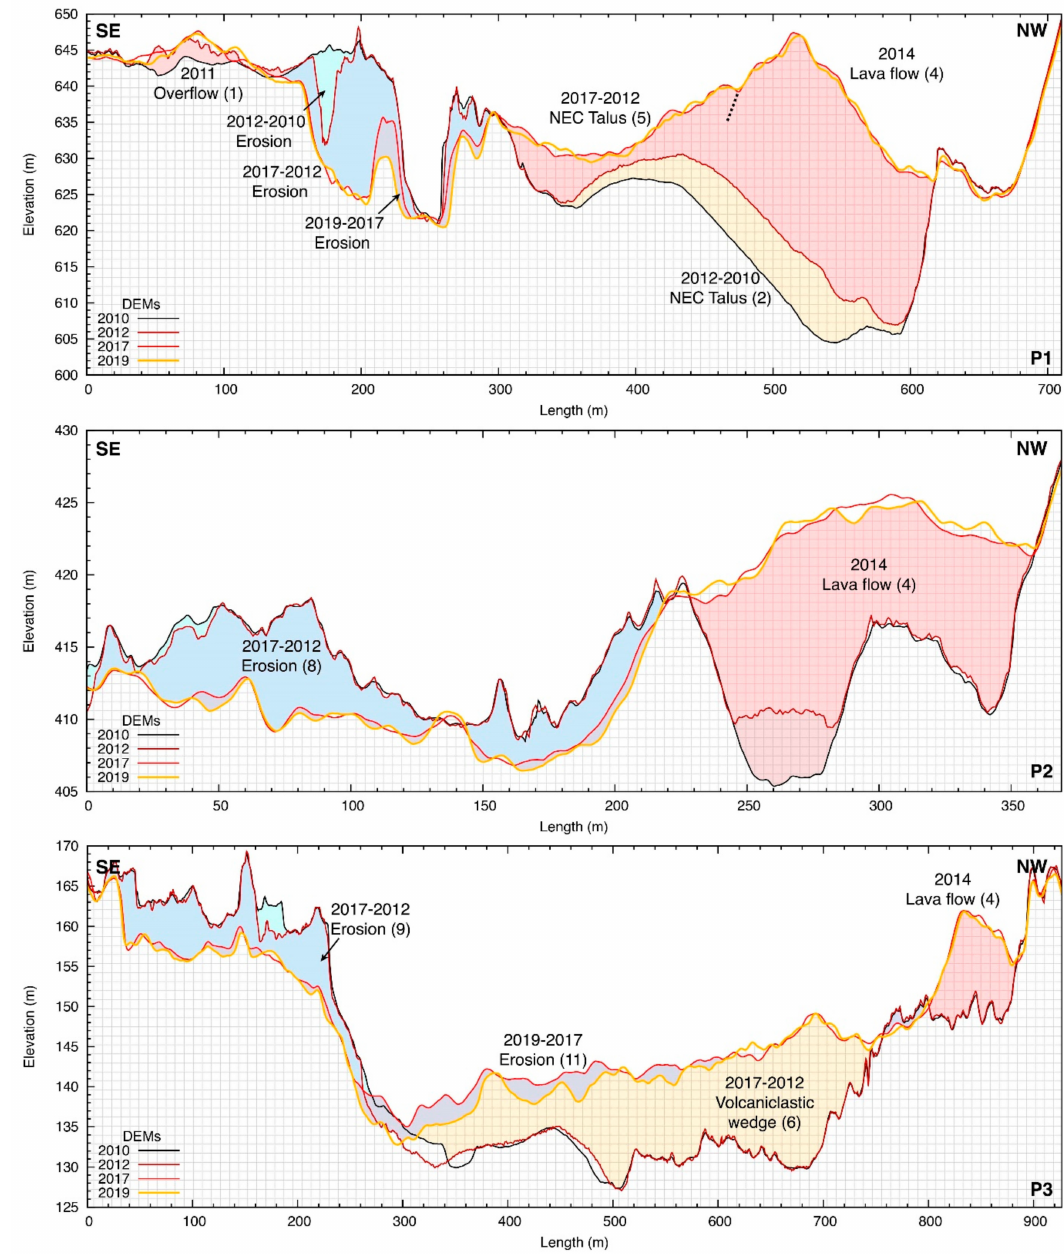
Figure 5. Profiles across the upper (P1), middle (P2) and lower section (P3) of the SdF. The locations of the profiles are represented in Figure 4d. Labels describe the observed phenomena, and the sectors shown in Figure 4 are reported in brackets. Erosion is illustrated in cold tones, and deposition is illustrated in warm tones. The most recent surface, i.e., the 2019 DEM, is marked by a squared pattern. The volume ( V ) emplaced or lost between two acquisitions was calculated from the DEM di ff erence (cid:80) ∆ x 2 ∆ z according to the equation: V = i [30], where x is the grid step and z i is the height variation i within grid cell i . These values were then summed up for all the cells in the selected areas in which the volume changes were calculated. An upper bound on the error for the volume estimate was given by assigning to each pixel the maximum possible error, i.e., Err V , high = A σ ∆ Z , where A is the investigated area. Thus, the errors provided here are reasonably overestimated